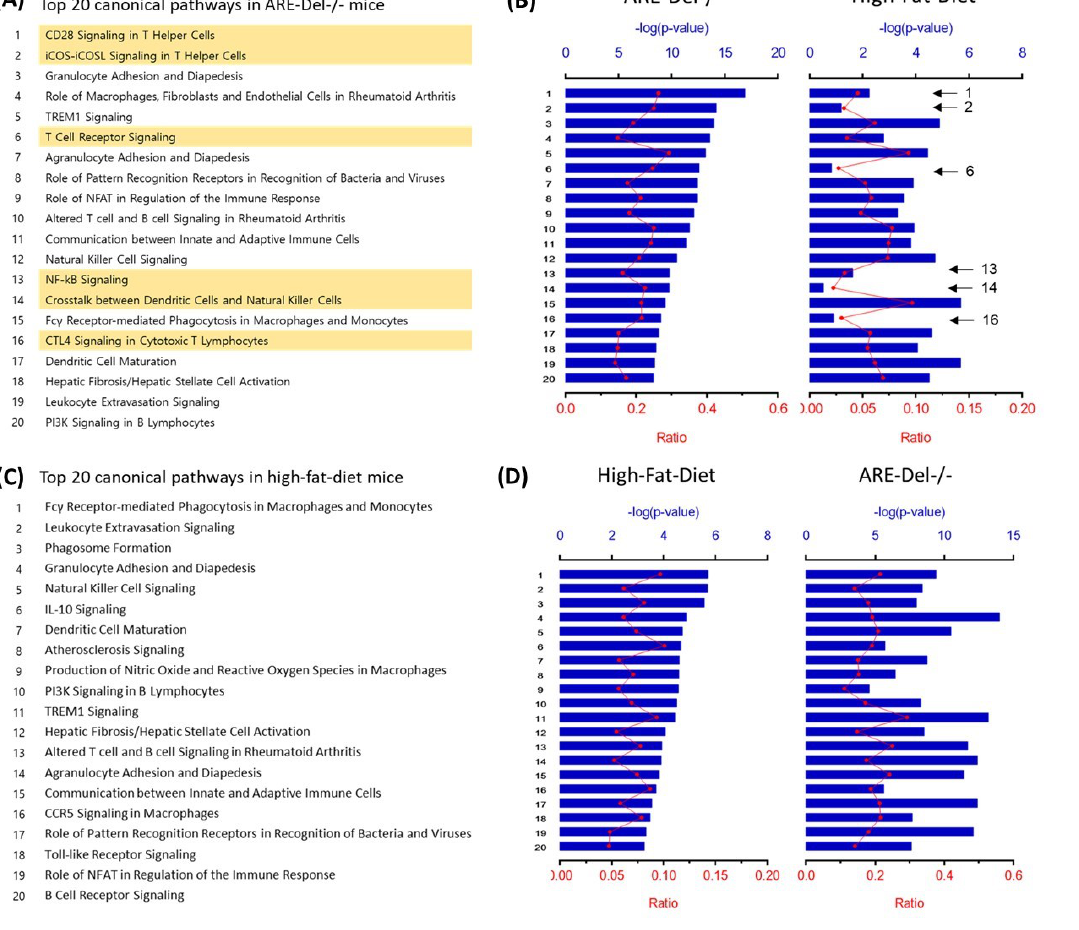
Figure 1. The comparison of altered pathways between high-fat-diet and ARE-Del -/- mice. ( A ) The top 20 altered pathways in ARE-Del -/- mice. Yellow marks represent pathways specifically increased in ARE-Del -/- mice compared tohigh-fat-diet mice; ( B ) Overlapping pathways of high-fat-diet mice were aligned with those in (A); ( C ) The top 20 altered pathways in high-fat-diet mice; ( D ) Overlapping pathways of ARE-Del -/- mice were aligned with those in ( C ). Ratio (bottom y-axis, red line) refers to the number of genes from the dataset divided by the total number of genes that make up that pathway from within the ingenuity pathway analysis (IPA) knowledge base. The -log of the p -value (top y-axis, bar) was calculated by Fisher’s exact